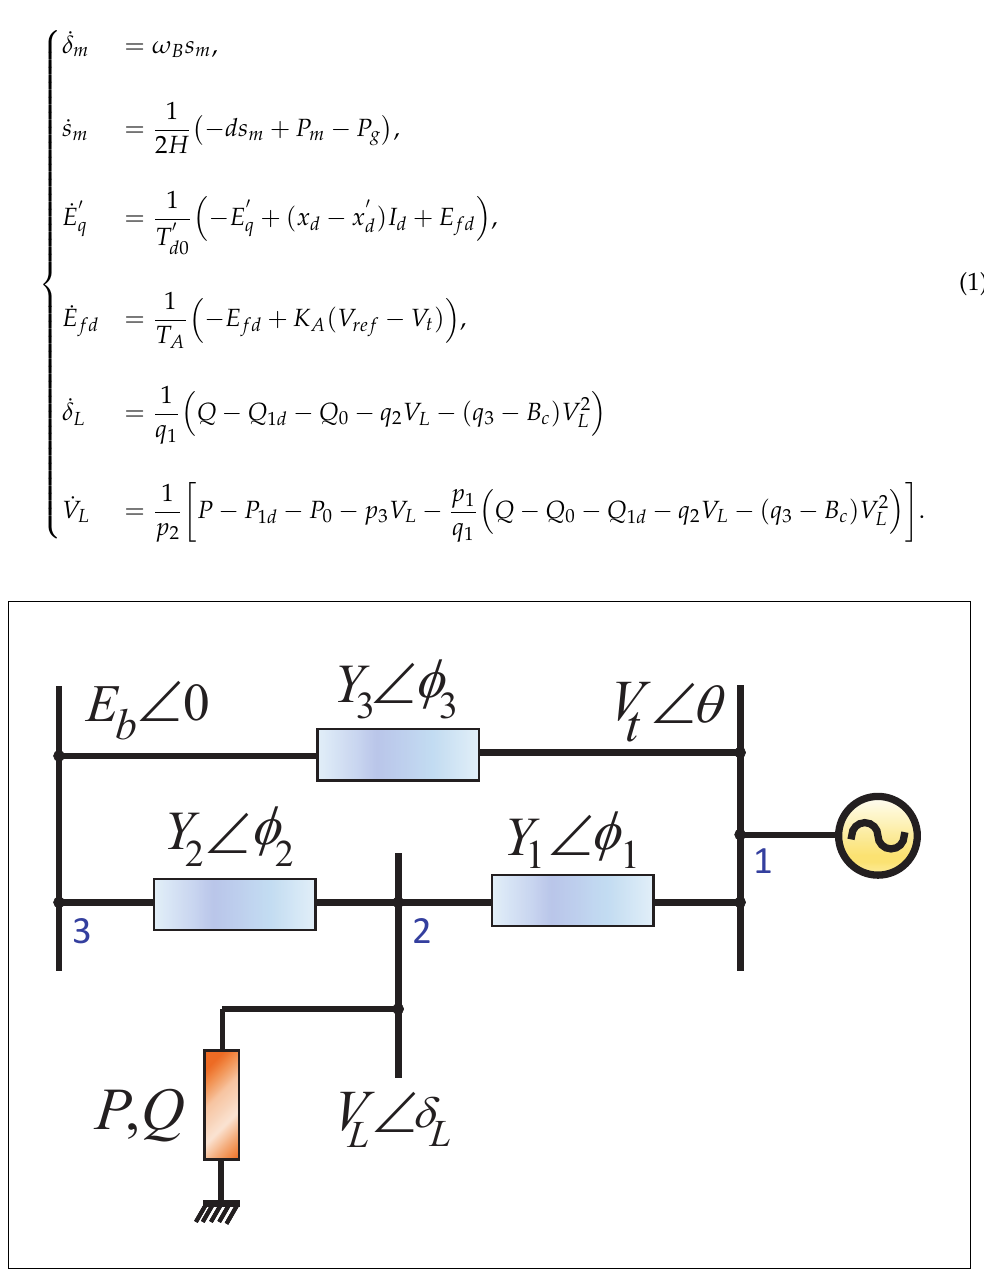
Figure 1. power system model with three